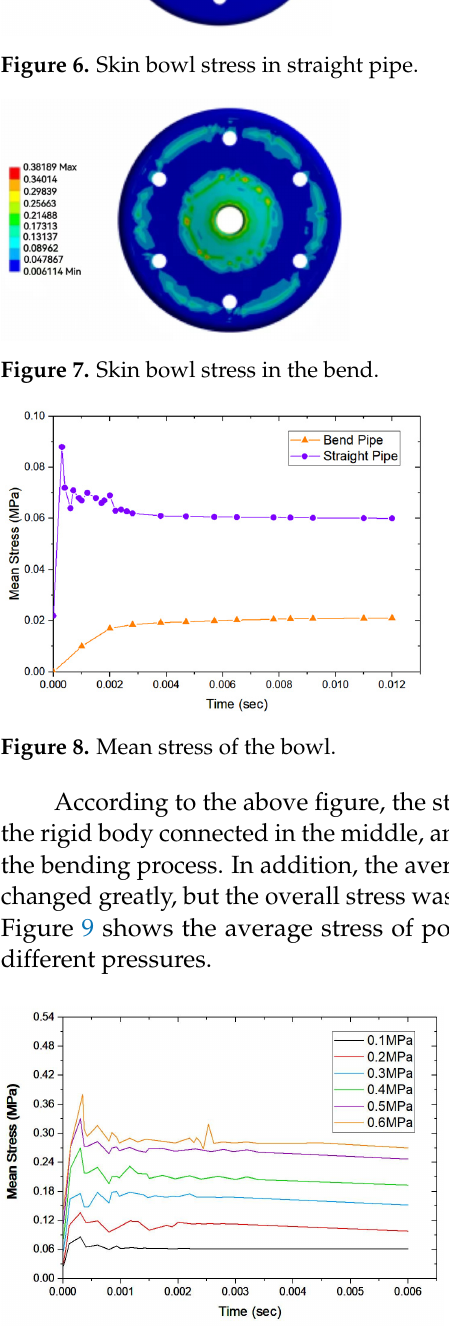
Figure 9. Average stress of leather bowl under di ff erent